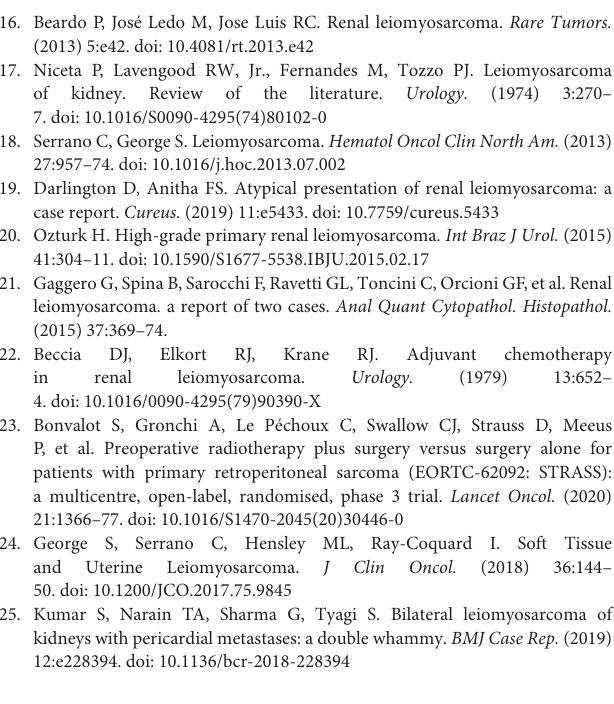
Table S1 | Clinicopathological characteristics of patients with primary renal leiomyosarcoma and kidney renal clear cell carcinoma after propensity score matching. aOthers included American Indian/Alaskan native and Asian/Pacific Islander. bNot married included divorced, separated, single (never married), unmarried or domestic partner and